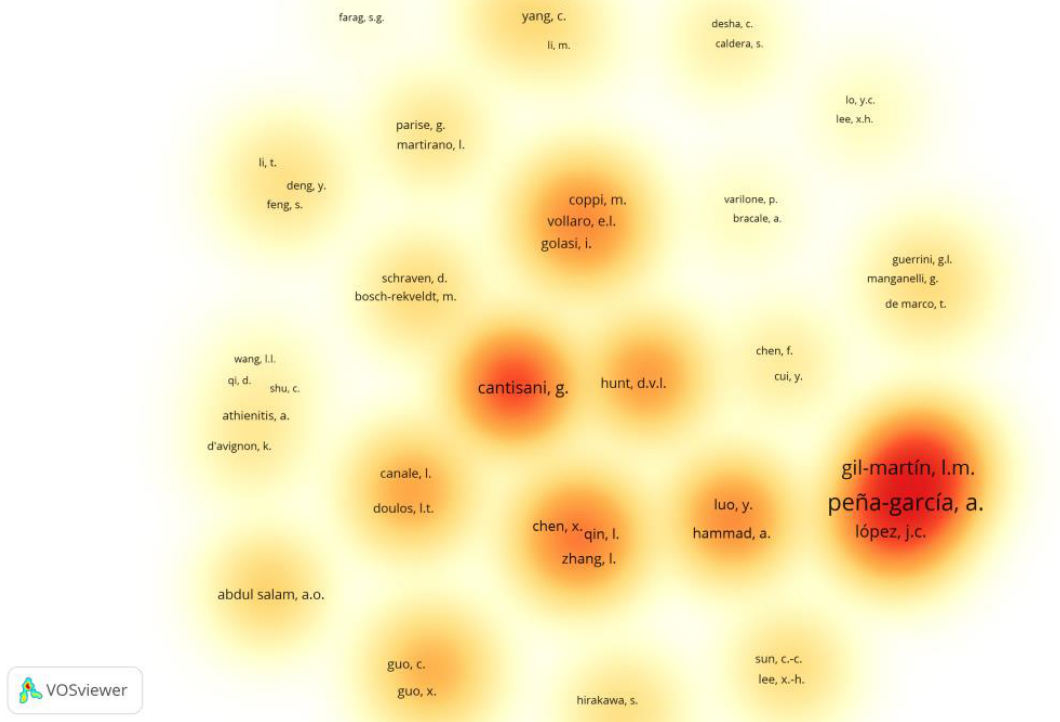
Figure 2. Density visualisation of potential author matches.